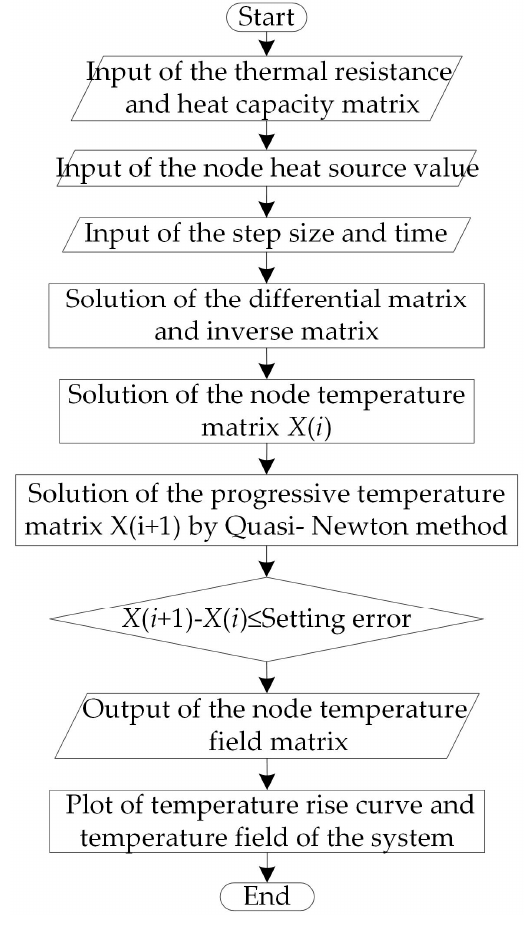
Figure 5. Solving procedure of the temperature field.